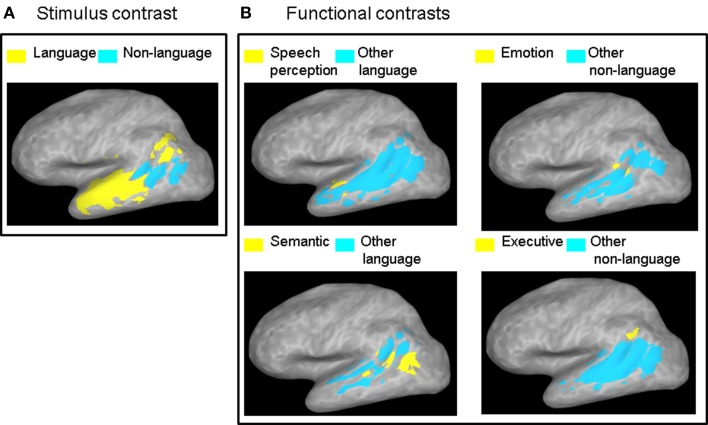
ALE contrast maps. Contrast maps of (A) the two stimulus categories and (B) each functional category relative to all the other functional categories in the same class. Maps are thresholded at a corrected probability of α < 0.05. Only functional contrasts resulting in significant differential ALE measurement in the left STS are displayed.